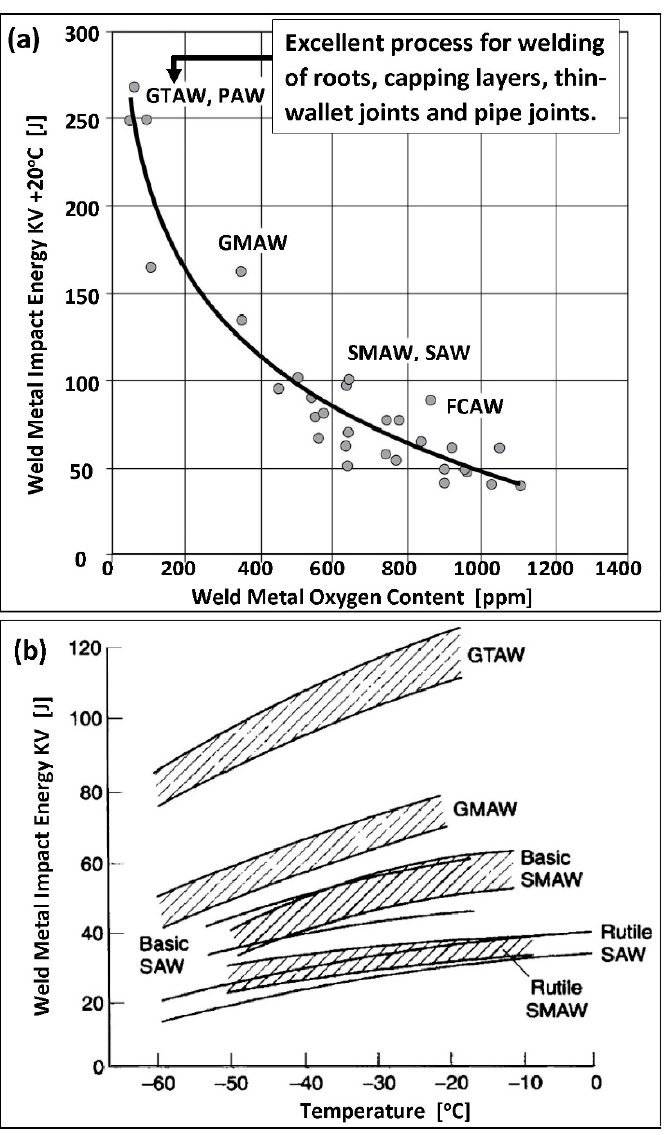
Figure 14. Breaking energy of the weld metal: ( a ) breaking energy KV determined at 20 °C as a function of oxygen content in the duplex weld metal, ( b ) breaking energy KV determined at 0–( − 60) °C, specified for various welding methods (according to [28]). The meaning of individual abbreviations is explained in the Abbreviations of this paper.